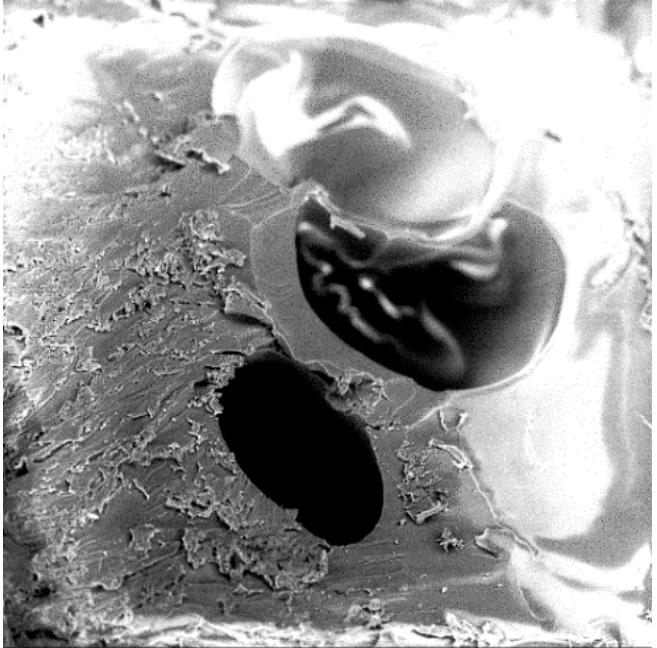
Figure 4. Scanning electron microscopic image of a cross-sectional view of a carbonated 3D-printed polymer sample.